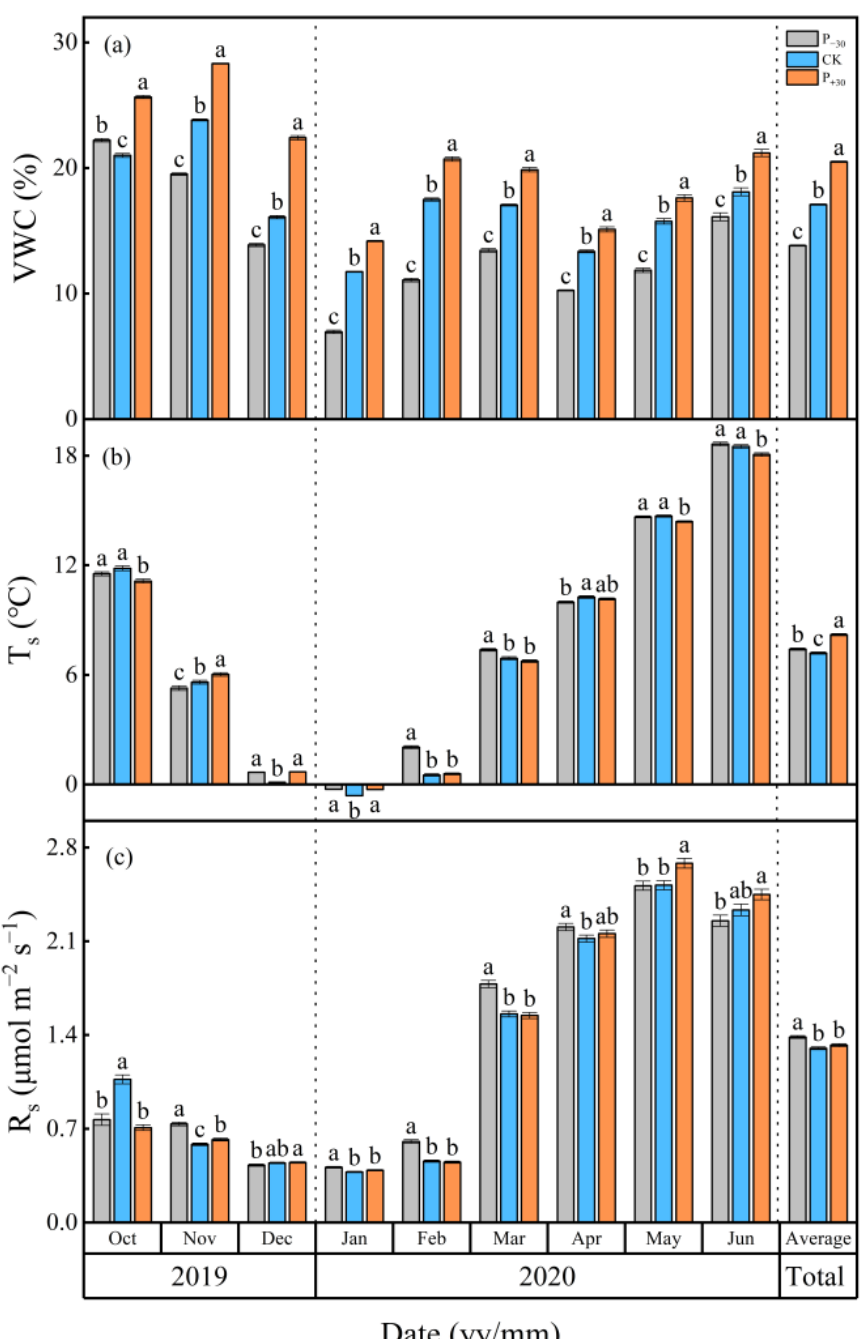
Figure 2. Monthly average dynamics of soil volumetric water content, VWC ( a ); soil temperature, T s ( b ); and soil respiration (R s ) ( c ) in three precipitation treatments (P − 30 = 30% decreased precipitation, CK = ambient precipitation, P +30 = 30% increased precipitation) during the winter wheat whole growth period. T s and VWC were measured at 10 cm depth. Vertical bars represent standard errors of the mean. Different letters represent significant differences ( p < 0.05) among the three precipitation treatments in the same month. Three precipitation treatments containing the same letter in the same month indicate nonsignificant differences ( p > 0.05).